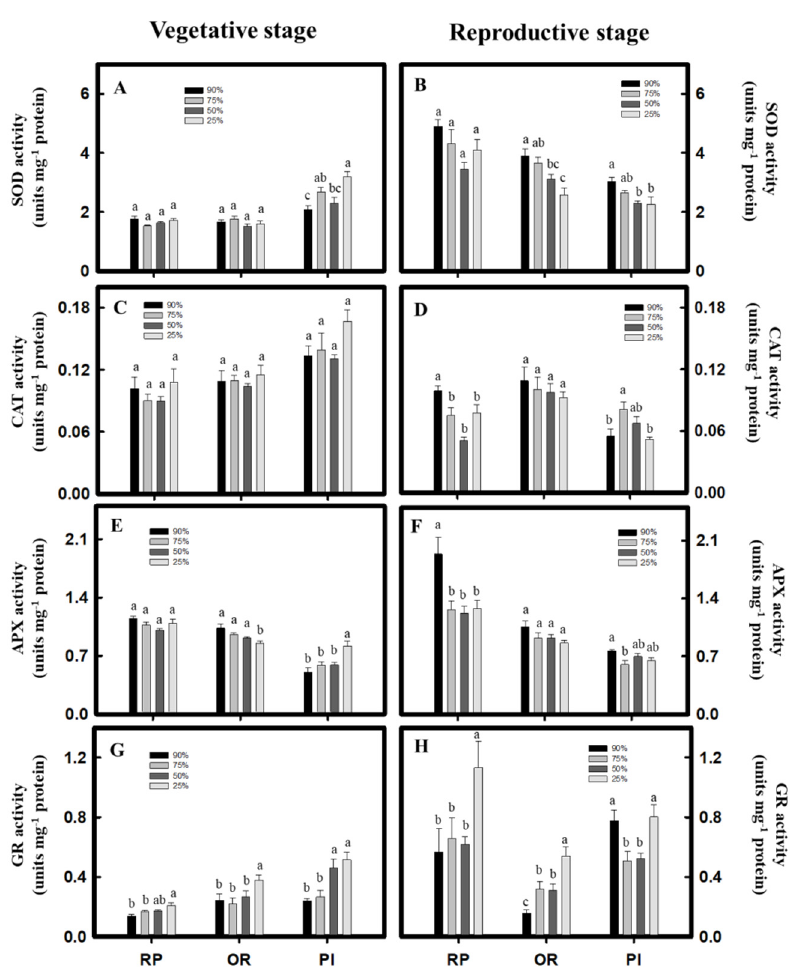
Figure 4. Effect of drought stress on antioxidant enzyme activities in C. formosana and C. quinoa . C. formosana RP variety, OR variety, and C. quinoa PI variety during vegetative stage (5 weeks after transplanting) and reproductive stage (8 weeks after transplanting); the SOD activity ( A , B ), CAT activity ( C , D ), APX activity ( E , F ), and GR activity ( G , H ) were investigated, respectively. Bars show means ± SE. Values with the same letter are not significantly different in treatments between the same variety by LSD ( p < 0.05, n = 4).